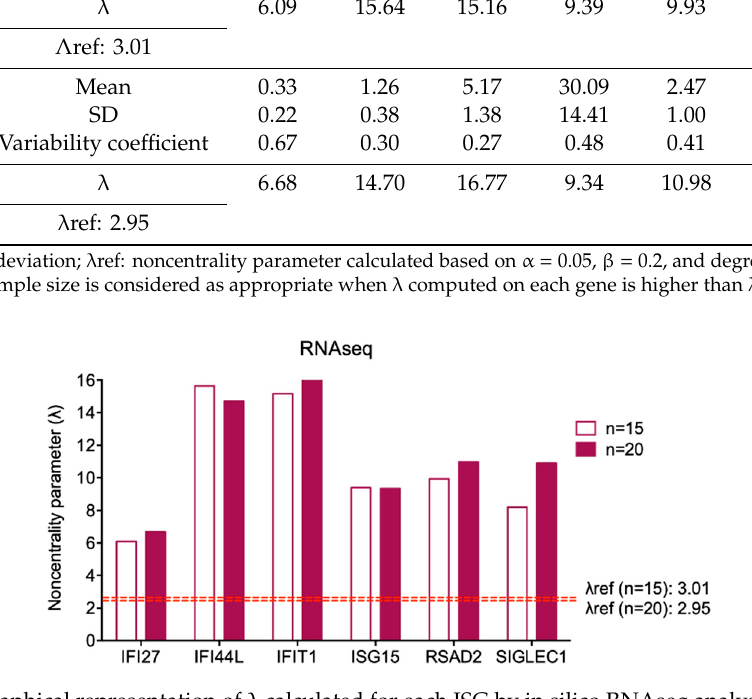
Figure 5. Graphical representation of λ calculated for each ISG by in silico RNAseq analysis. The λ refs for fifteen and twenty subjects are displayed by the red dashed line and reported in the figure. Sample size is considered appropriate when λ computed on each gene is higher than λ ref.